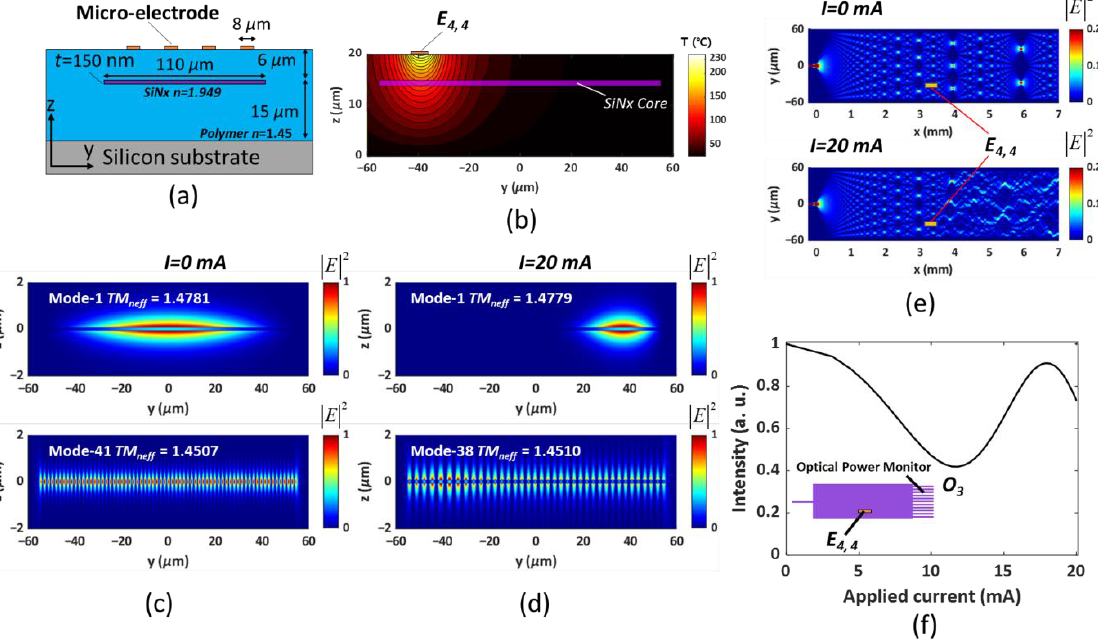
Figure 2. ( a ) Cross-section of the waveguide. ( b ) Temperature gradient by thermal simulation when 20 mA current is applied to the heater electrode E 4,4 . ( c , d ) Comparison of the eigenmodes and ( e ) the corresponding multimode interference patterns with the heater ( E 4,4 ) off and on. ( f ) Nonmonotonic and nonlinear relation between the current applied to E 4,4 and the intensity change at O 3 as a result of the complex electro-thermo-optic changes.